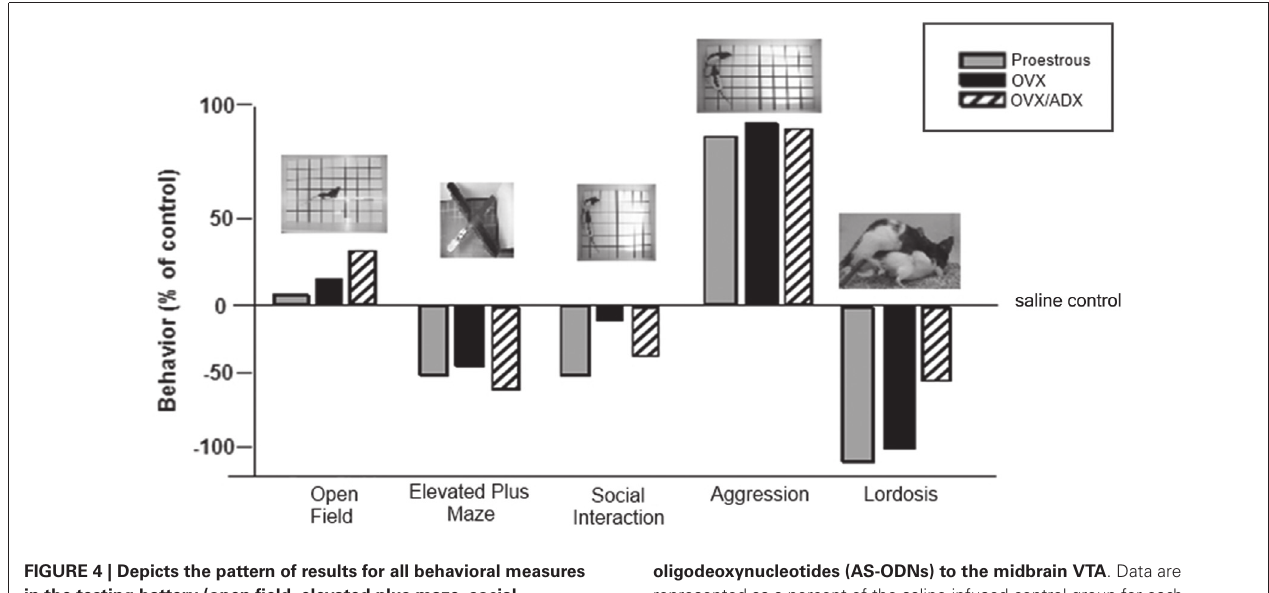
FIGURE 4 | Depicts the pattern of results for all behavioral measures in the testing battery (open field, elevated plus maze, social interaction and paced mating) of rats proestrous (PRO), ovariectomized (OVX) and estradiol-primed, or OVX and adrenalectomized (OVX/ADX) estradiol-primed rats infused with saline vehicle or pregnane xenobiotic receptor (PXR) antisense